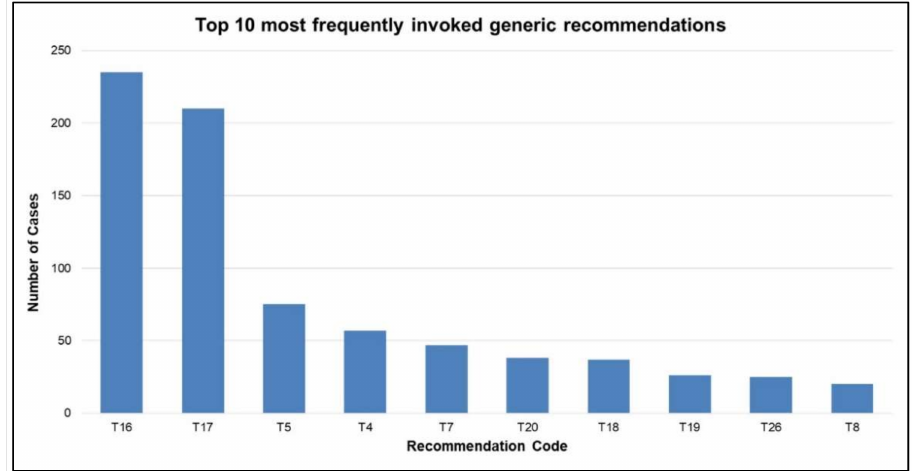
Figure 17. Top 10 frequent generic